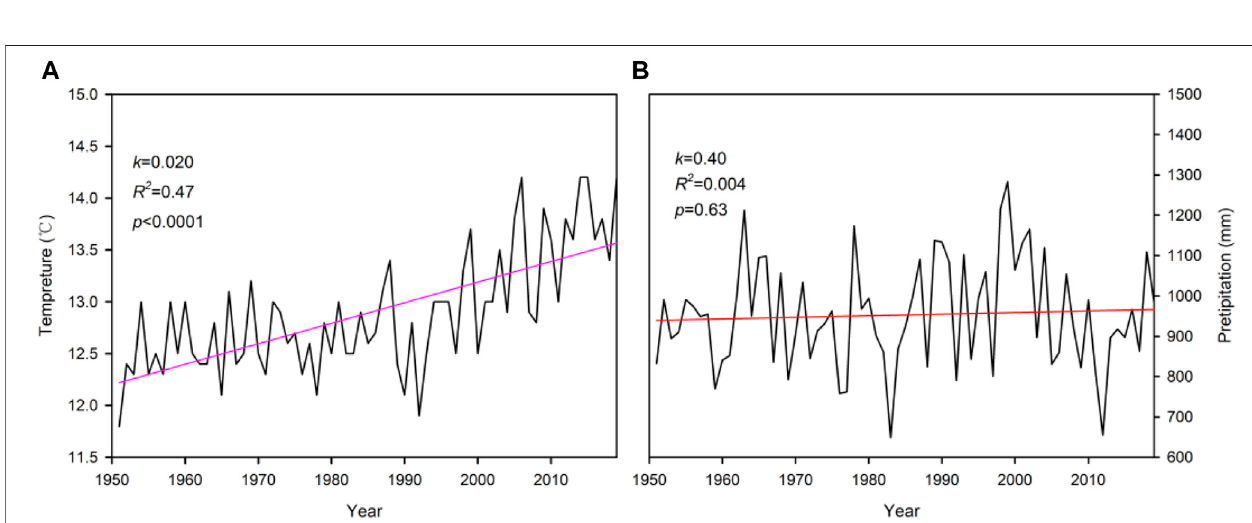
FIGURE 7 | Changes in (A) the annual air temperature and (B) the precipitation at Lijiang meteorological station, near Yulong Snow Mountain and Lijiang city, Yunnan, China, from 1951 to 2019.